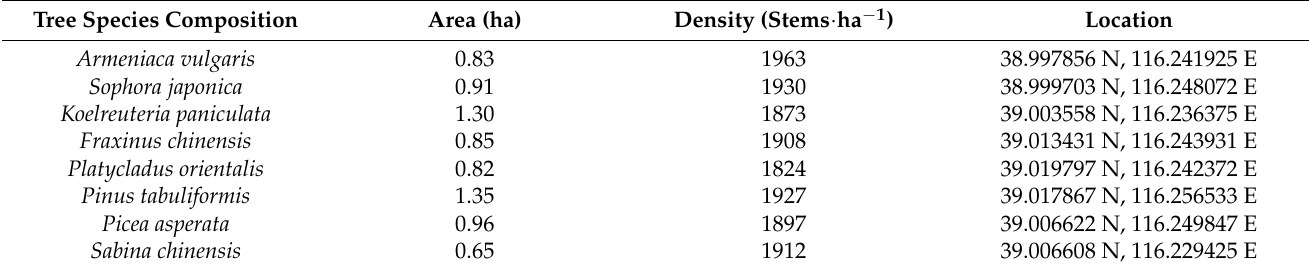
Table 1. Basic characteristics of studied